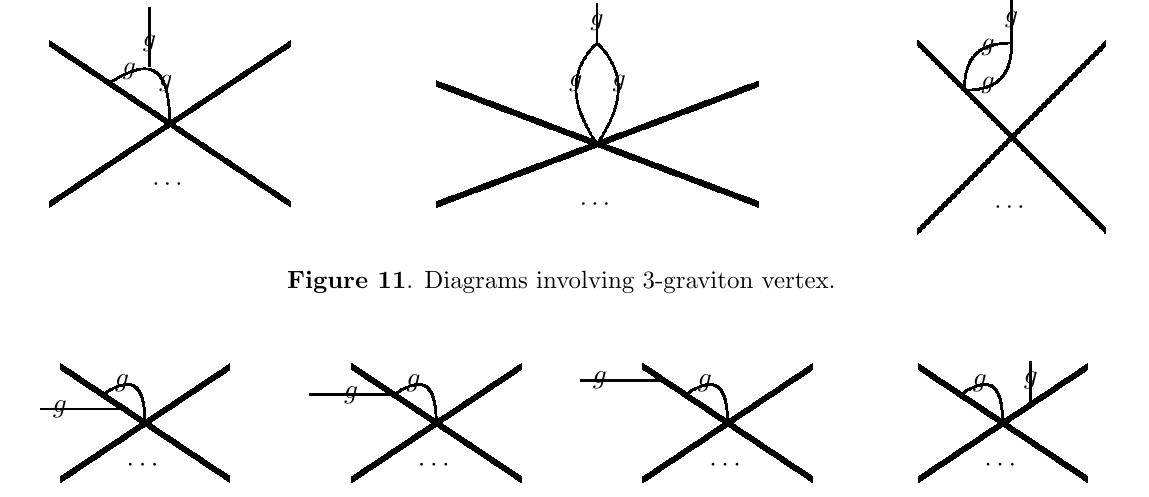
Figure 12 . Diagrams where the internal graviton attaches to the n -point vertex.